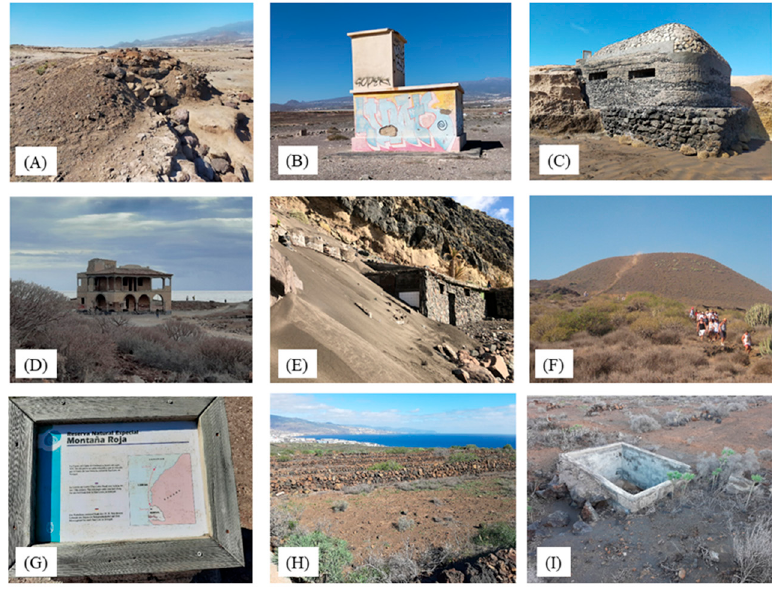
Figure 6. ( A ): lime kiln; ( B ): control tower of the ancient airfield; ( C ): World War II bunker; ( D ): sanatorium; ( E ): former agricultural warehouses; ( F ): religious festivity or pilgrimage of El Socorro; ( G ): panel about cultural heritage; ( H ): abandoned crops; ( I ): water pond. Location: ( A – C , G ), en El Médano; ( D ), en Punta de Abona; ( E ), en Antequera; ( F , H , I ), Malpaís de Güimar. Source: authors.